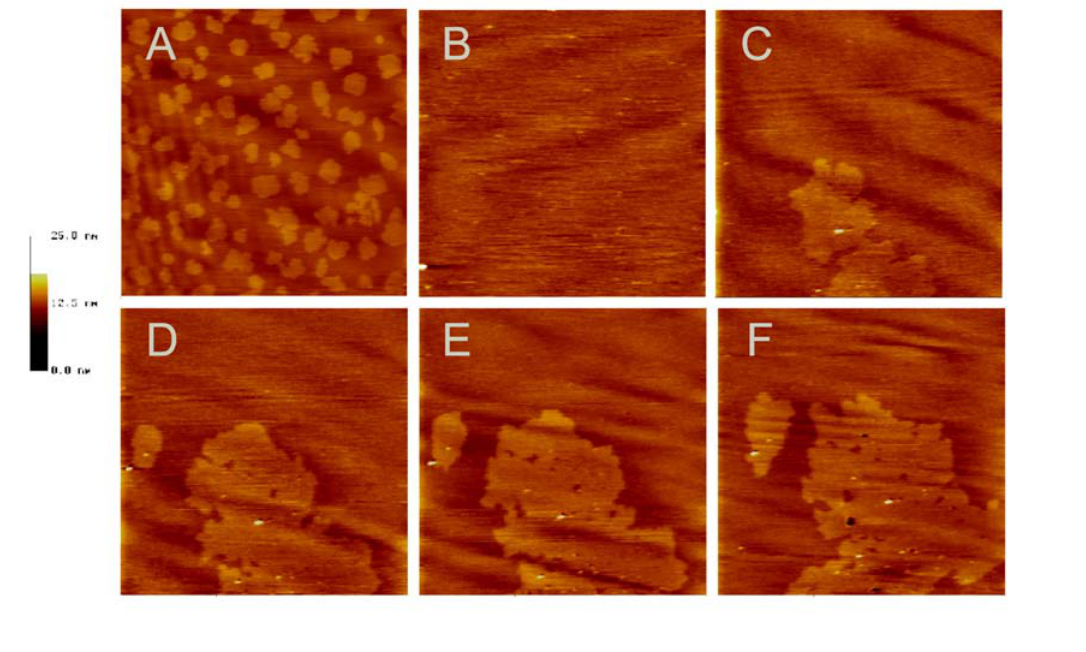
FIGURE 7 . The size of ordered domains depends on experimental conditions. (A) 1:1 DOPC/DPPC bilayers examined in buffer 120 min after a rapid temperature quench from 60 to 23°C; (B) upon heating of the bilayer to 45°C under the microscope, gel phase microdomains disappear; (C to F) sample temperature was linearly decreased from 45 to 25°C in 2 h, promoting the formation of large domains; (C, D, E, and F) 40, 80, 100, and 120 min (scan size 15 × 15